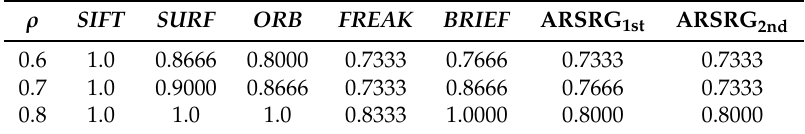
Table 2. Quantitative comparison, using the recall measure, among SIFT [8], SURF [29], ORB [30],